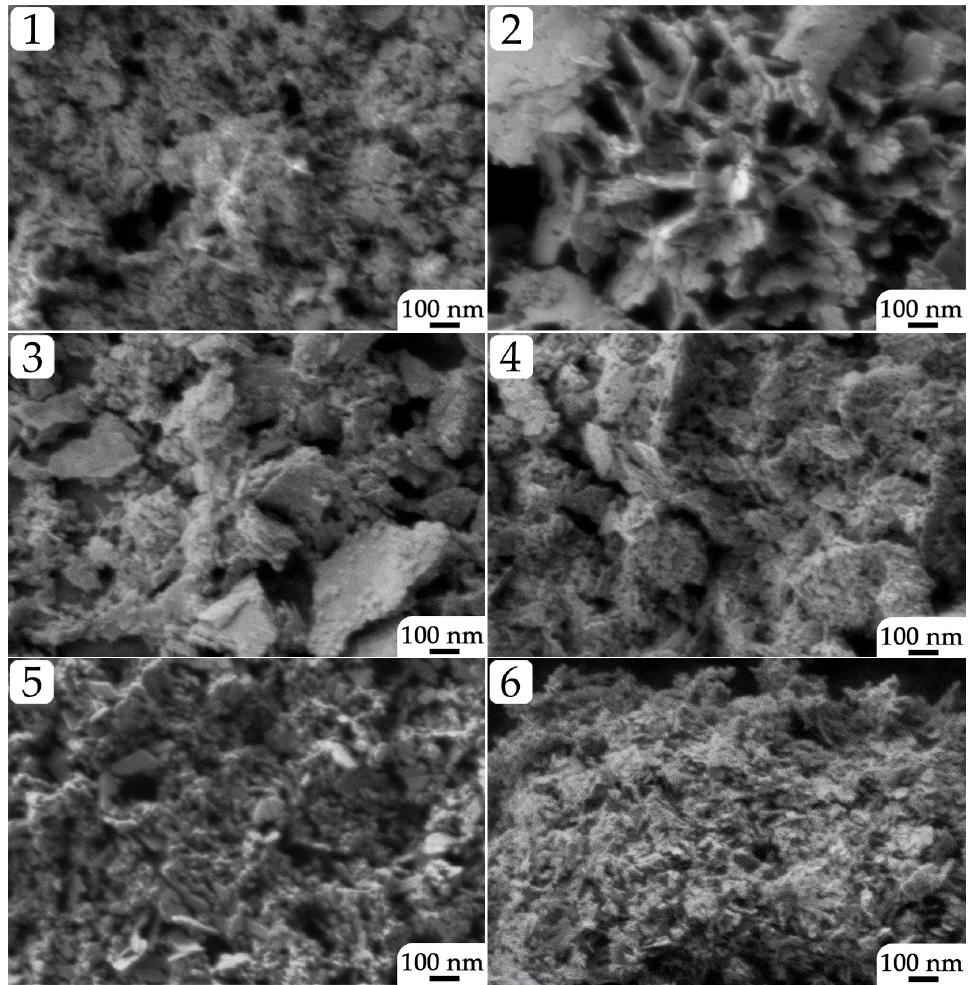
Figure 4. Microstructure of the NiO nanopowders (samples 1–6) obtained after additional heat treatment (400 °C, 1 h; according to SEM data).